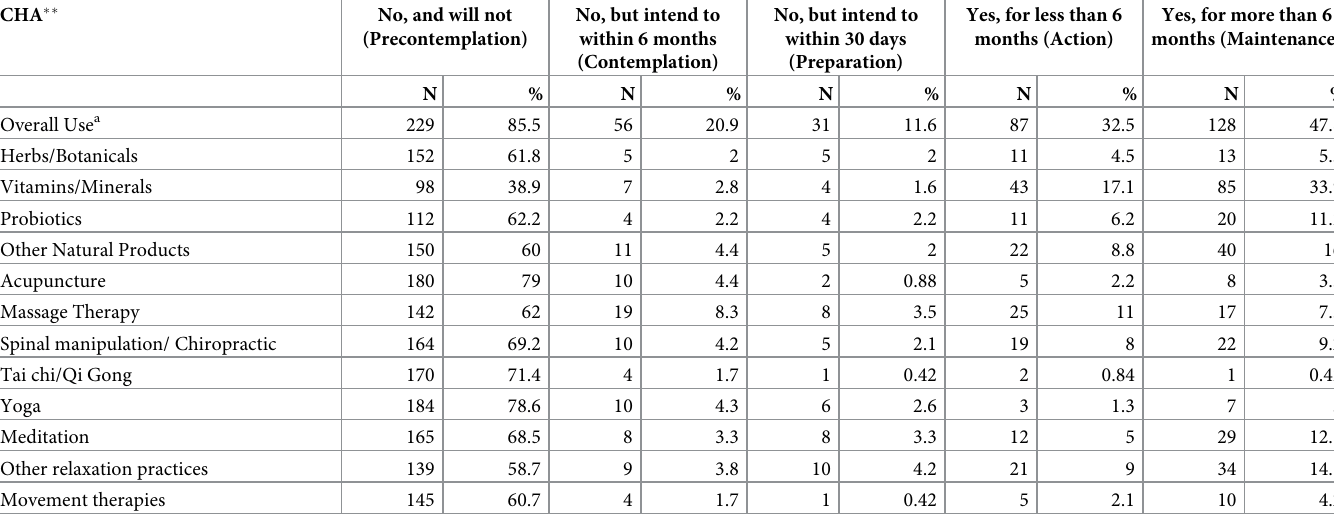
Table 4. Complementary Health Approaches (CHAs) used for pain among Appalachian patients seeking conventional pain management by Health behavior stage of change, Complementary Health Approaches for Pain Survey (CHAPS), WV,